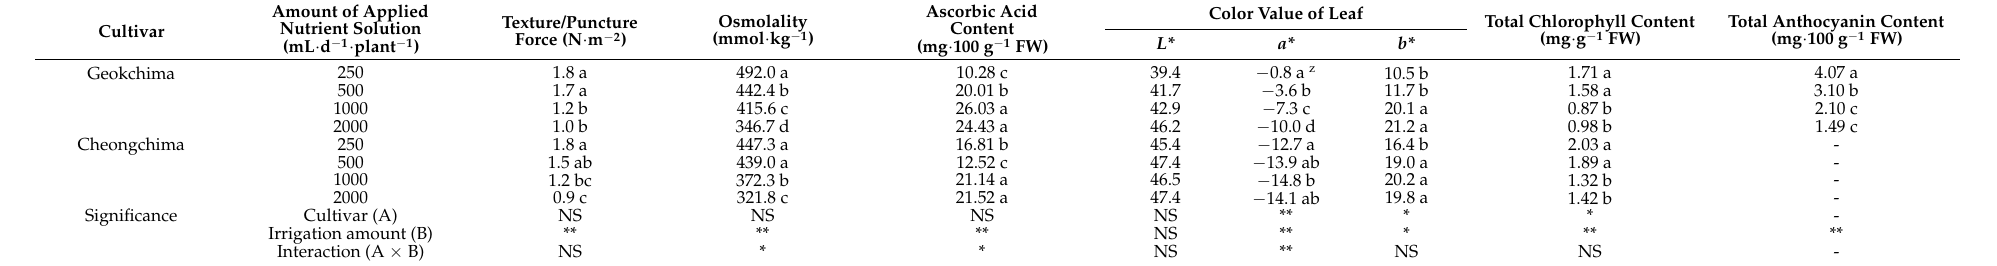
Table 3. Physicochemical and nutritional quality parameters of harvested leaf lettuce as influenced by cultivar and amount of applied nutrient solution in perlite